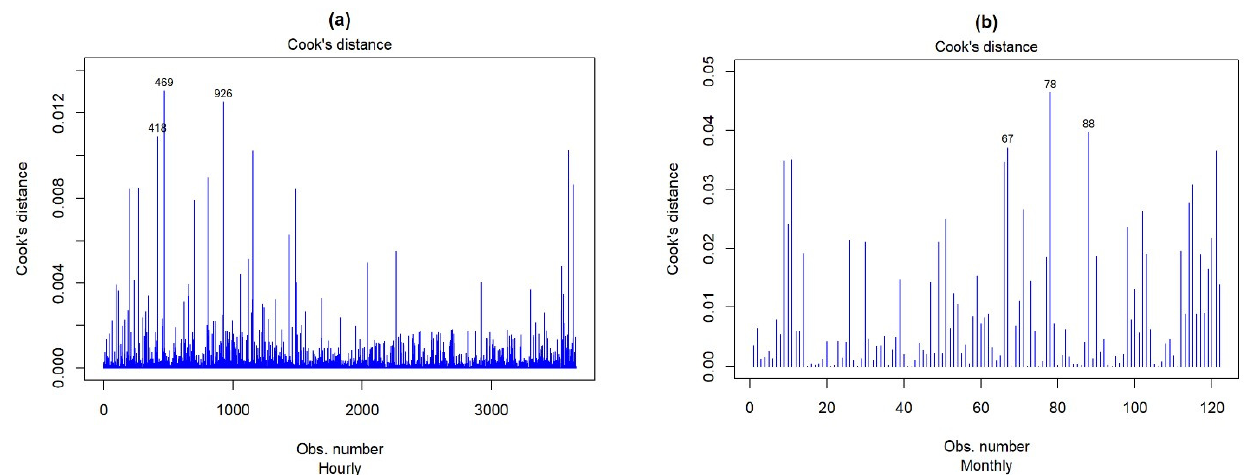
Figure 15. Cook’s distance plot between hourly vs. monthly profiles. ( a ) Shows the positions of the influence values for the hourly GHI profile. ( b ) Shows the positions of the influence points for the monthly GHI profile.